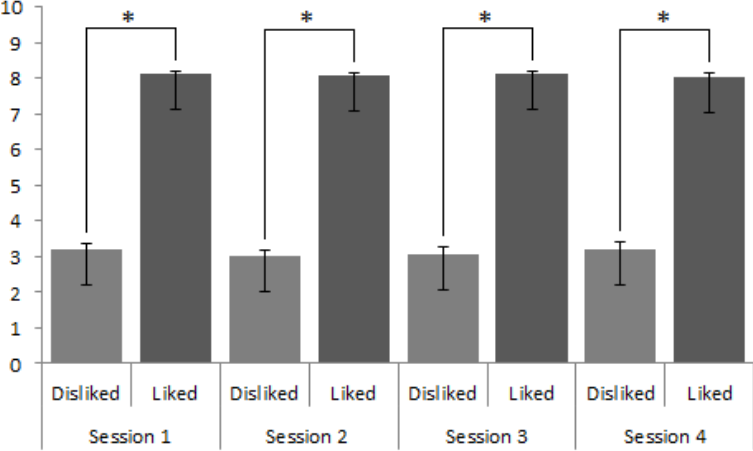
Figure 2. Self-report responses towards liked and disliked brands throughout all four sessions. While liked brands were consistently rated as more positive compared to disliked brands across all sessions (* denotes p < 0.001) these ratings did not change between